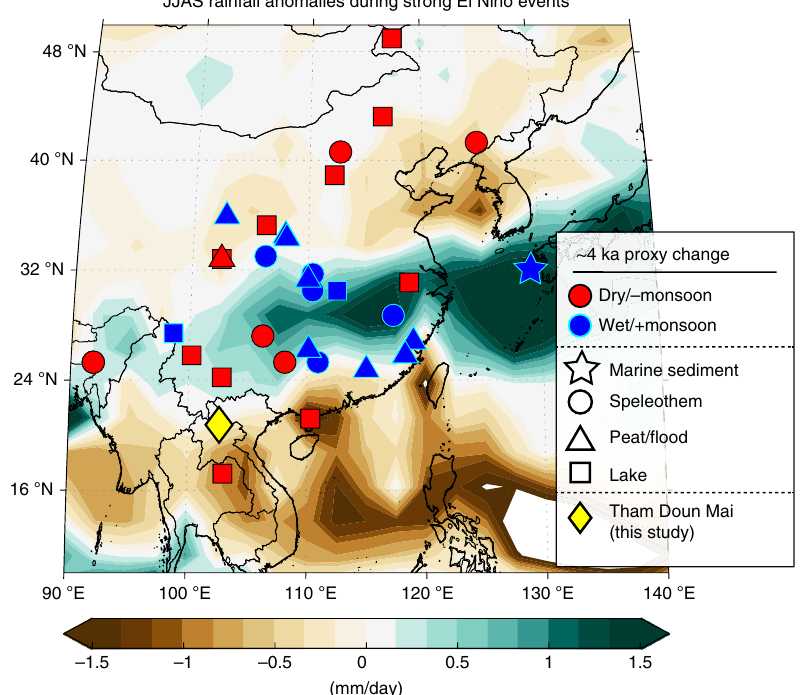
Fig. 1 Location of Tham Doun Mai cave (diamond) and other climate proxy sites mentioned in the text. Locations of climate proxy records across East Asia showing relative hydroclimate changes at ≈ 4 ka as inferred from the synthesis in Supplementary Table 1. Background shading shows Global Precipitation Climatology Project (GPCP) average June-September (JJAS) rainfall anomalies during the large 1982/1983, 1998/1999, and 2015/2016 El Niño